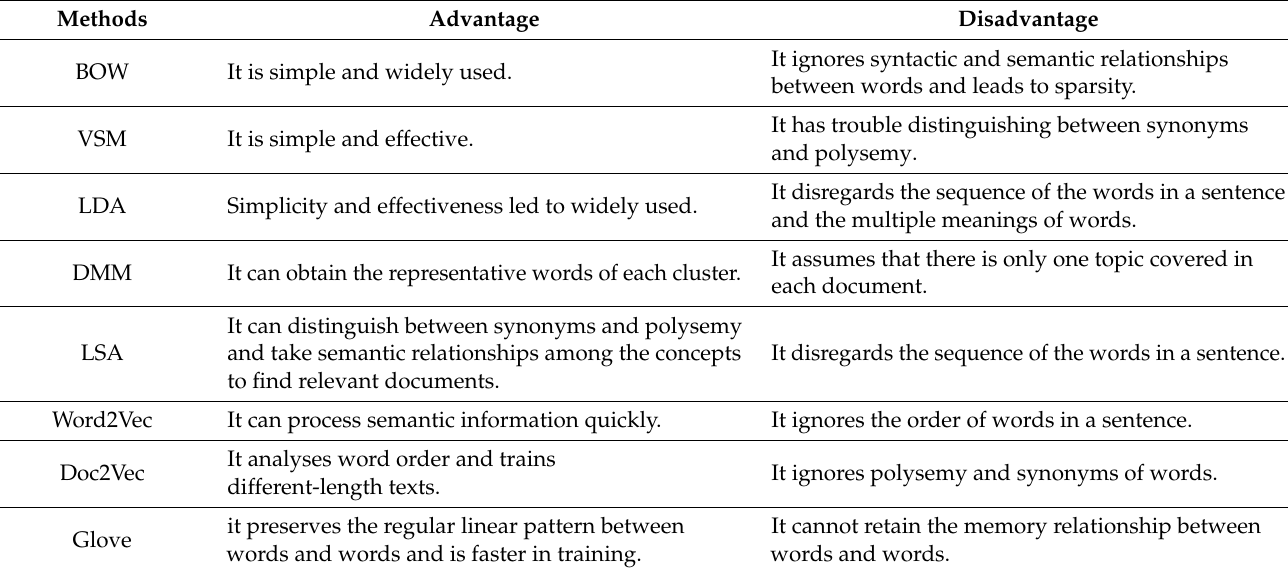
Table 2. Advantages and disadvantages of non-deep-learning measures.